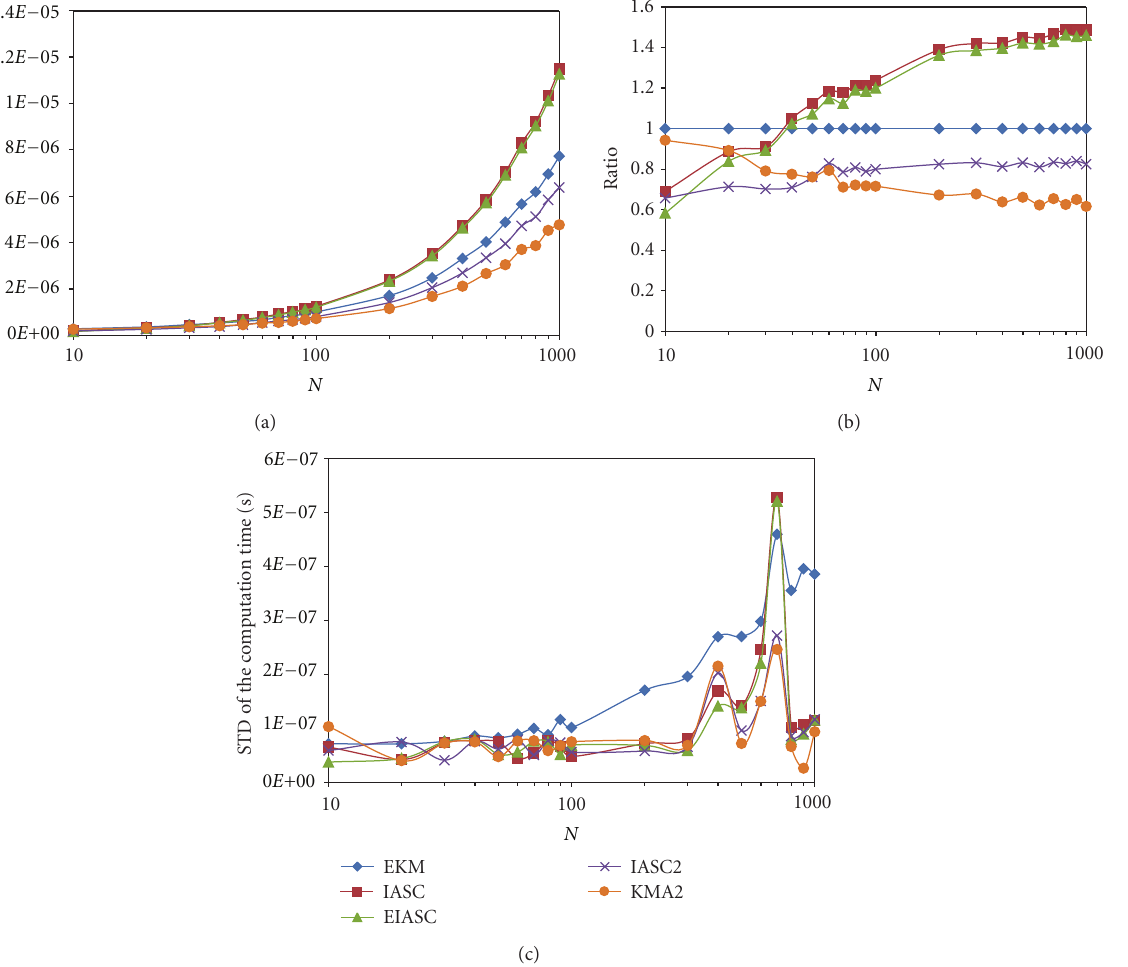
Figure 3: Uniform random FOU results (compiled language implementation of the algorithms). (a) Average computation time, (b) ratio with respect to the EKMA, and (c) standard deviation of the computation